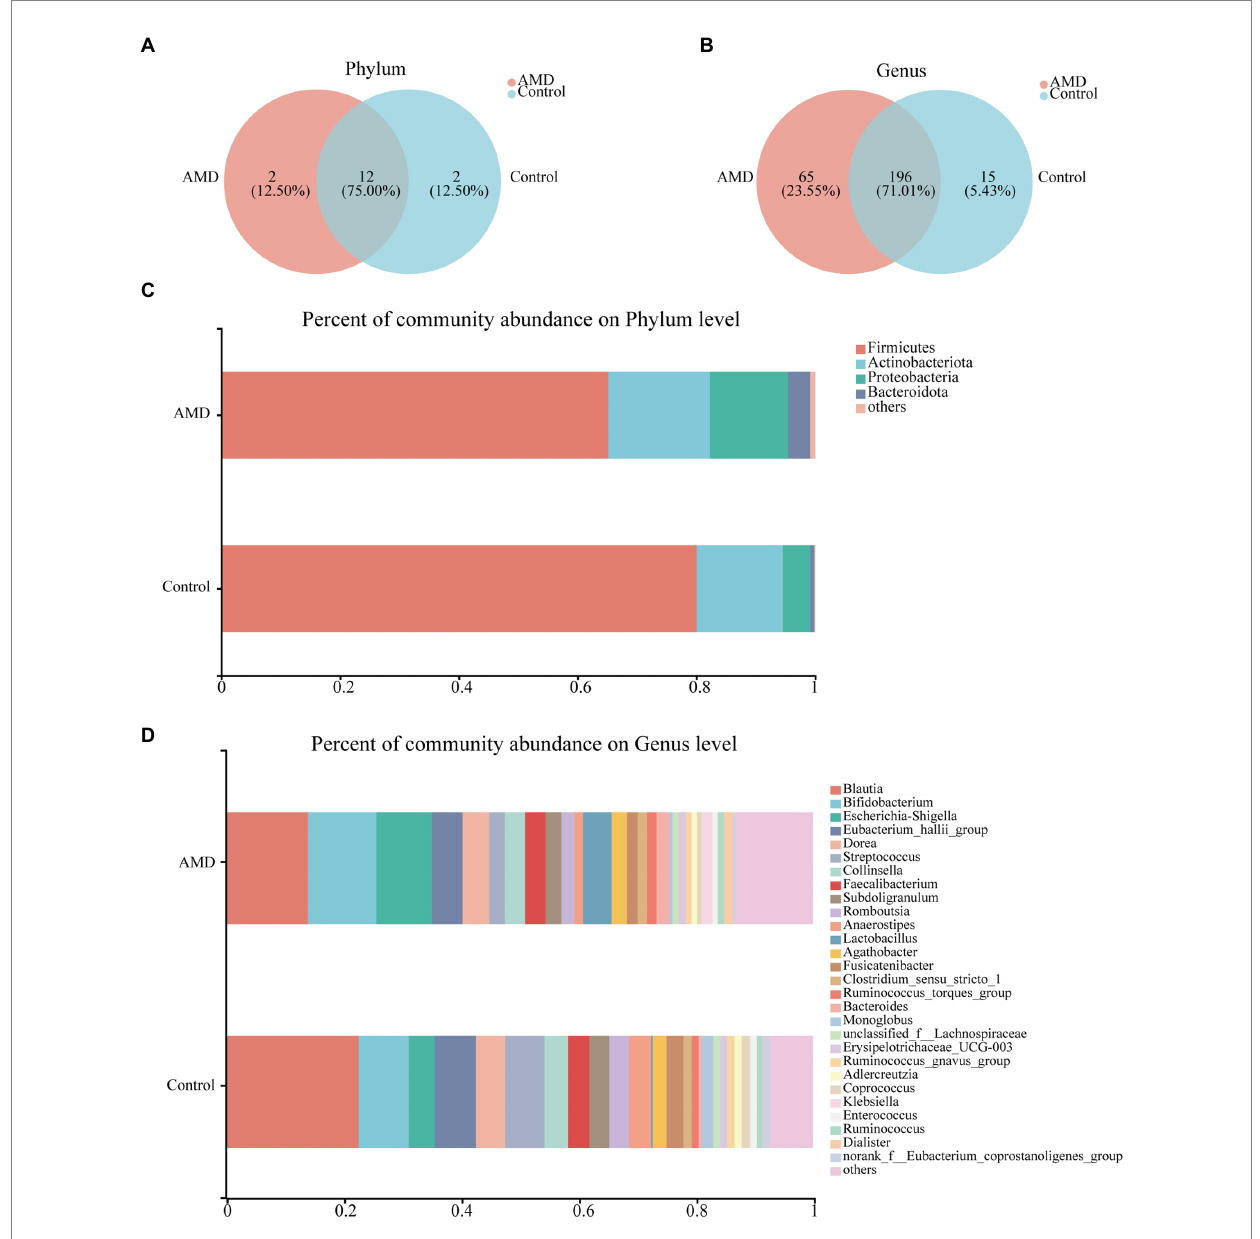
FIGURE 2 Fecal bacterial composition in patients with AMD and controls. (A,B) The species Venn diagram at the phylum and genus level, overlapping parts indicated common species. (C) Taxonomic distributions of bacteria at the phylum level in the AMD patients and controls. (D) Taxonomic distributions of bacteria at the genus level in the AMD patients and